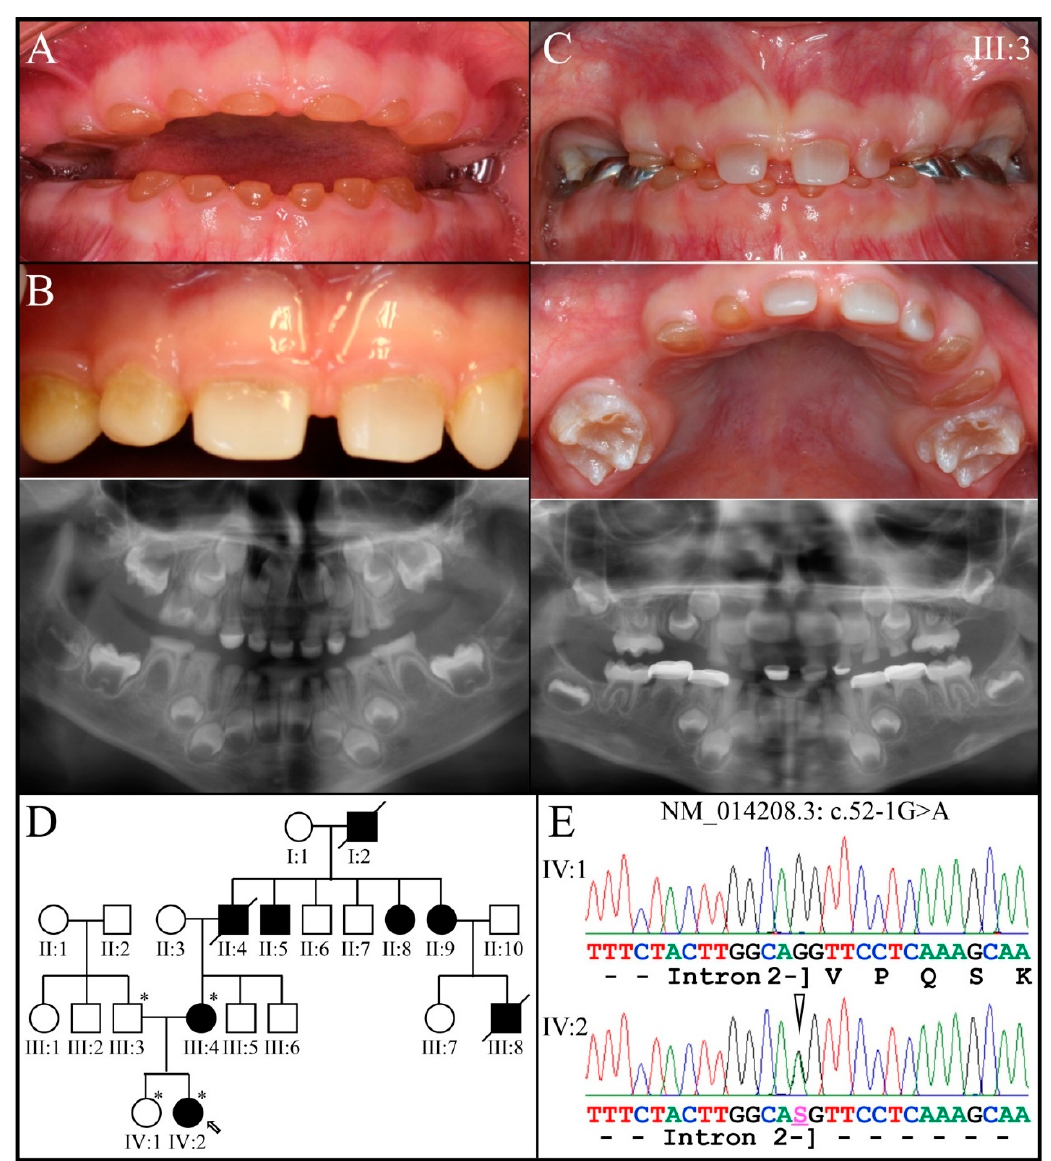
Figure 3. Family 2 from Turkey . ( A ): The dental phenotype of the primary dentition at 3-years 10-months showed amber-brown discoloration with severe enamel attrition and exposed dentin. ( B ): Composite restorations were completed on the primary anterior teeth and a panorex radiograph obtained. ( C ): The dental phenotype at 6-years, 1-month showed accelerated eruption of permanent first molars, with bulbous molar crowns. ( D ): Four-generation pedigree of the family. ( E ): Sanger sequence chromatograms showing the heterozygous DSPP 5 ′ splice junction mutation (NM_014208.3: c.52 − 1G>A). The “S” abbreviation at the heterozygous mutated position (arrowhead) indicates “strong” (G or C). Key : * denotes enrolled participants.